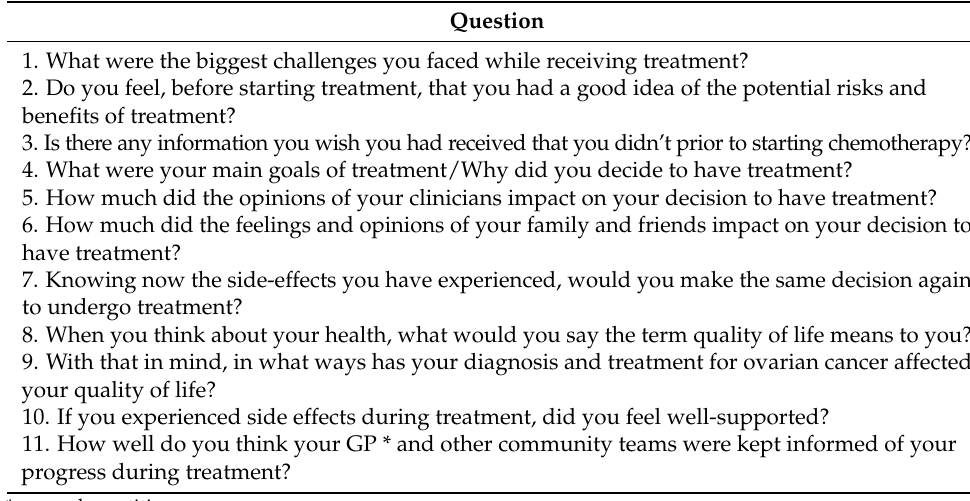
Table 1. Semi-structured interview